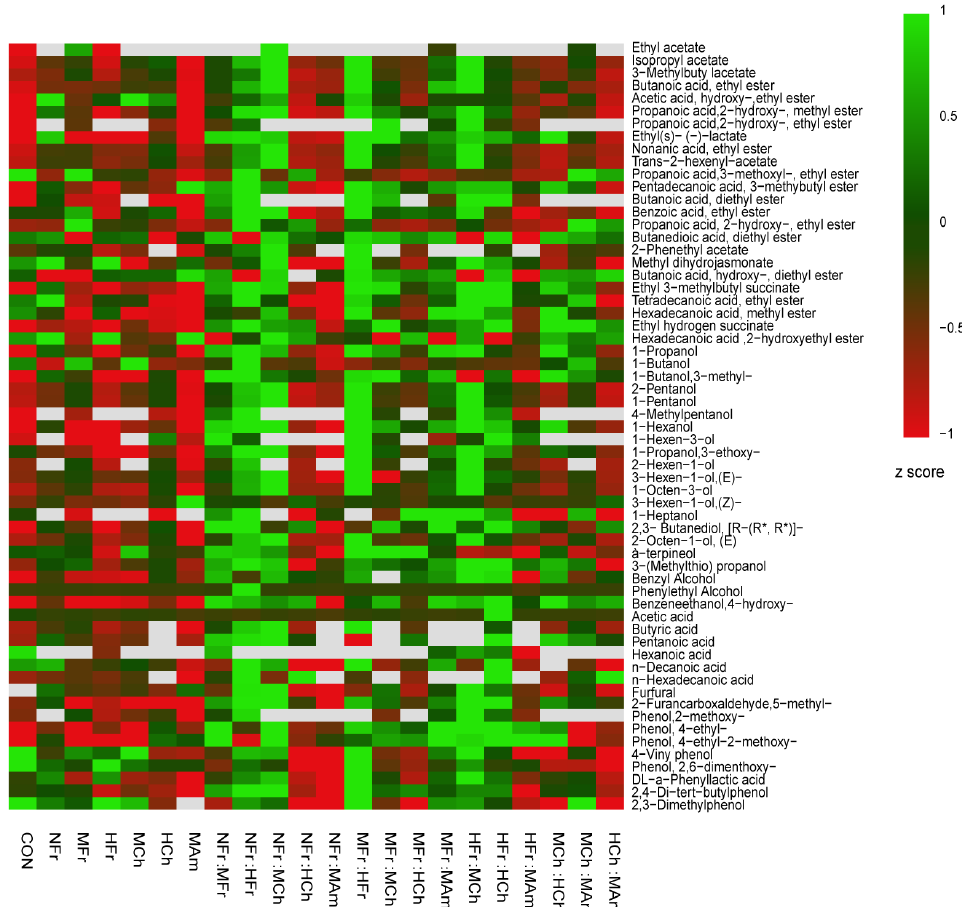
Figure 1. Heatmap representation of the GC–MS-determined aroma content of compounds in wines aged with different oak chips. In normalized mapping, the negative value is lower than the average value of all numbers, and the aroma content increases from red to green.